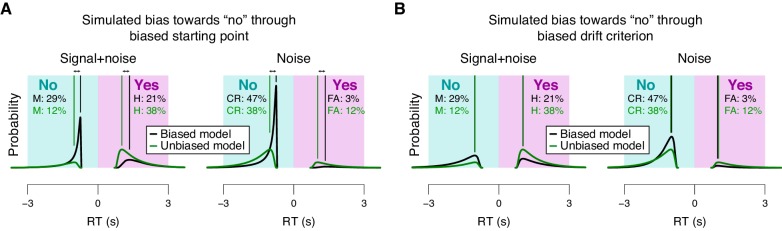
Effects of starting point vs. drift criterion on RT distributions.Analytical RT distributions sorted by the four SDT categories: ‘yes’- and ‘no’-choices, as well as signal+noise and noise trials. Within each category, RT distributions are shown separately for a biased model (black) and an unbiased model (green), whereby biased model refers to a model producing unequal fractions of ‘yes’- and ‘no’-choices. RTs for ‘no’-choices were sign-flipped for illustration purposes. A conservative choice bias was implemented in two separate mechanisms in the two panels, both producing the same change on the fraction of choices. These mechanisms have distinguishable effect on the shape of the RT distributions, most evident in the mode. (A) Conservative choice bias through setting the starting point of the accumulation process closer to the ‘no’-bound. Straight lines, mode (i.e., maximum) of the analytical RT distributions. A shift in starting point produced a substantial shift of the mode of the RT distribution (compare black and green vertical lines). (B) Conservative choice bias through changing drift criterion in the direction of the ‘no’-bound. This shift in drift criterion had a negligible effect on the mode of RT distributions (green and black vertical lines are on top of one another).